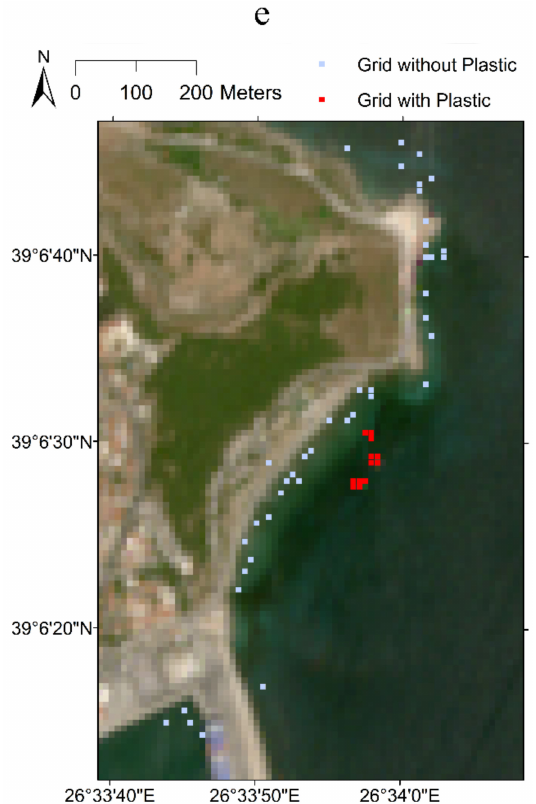
Figure 2. Sentinel-2 image and training set showing grid locations with and without floating plastic at ( a ) Limassol, Cyprus, collected on 15 December 2018, ( b ) Mytilene, Greece, collected on 7 June 2018, ( c ) Mytilene, Greece, collected on 18 April 2019, ( d ) Mytilene, Greece, collected on 3 May 2019 and ( e ) Mytilene, Greece, collected on 7 June